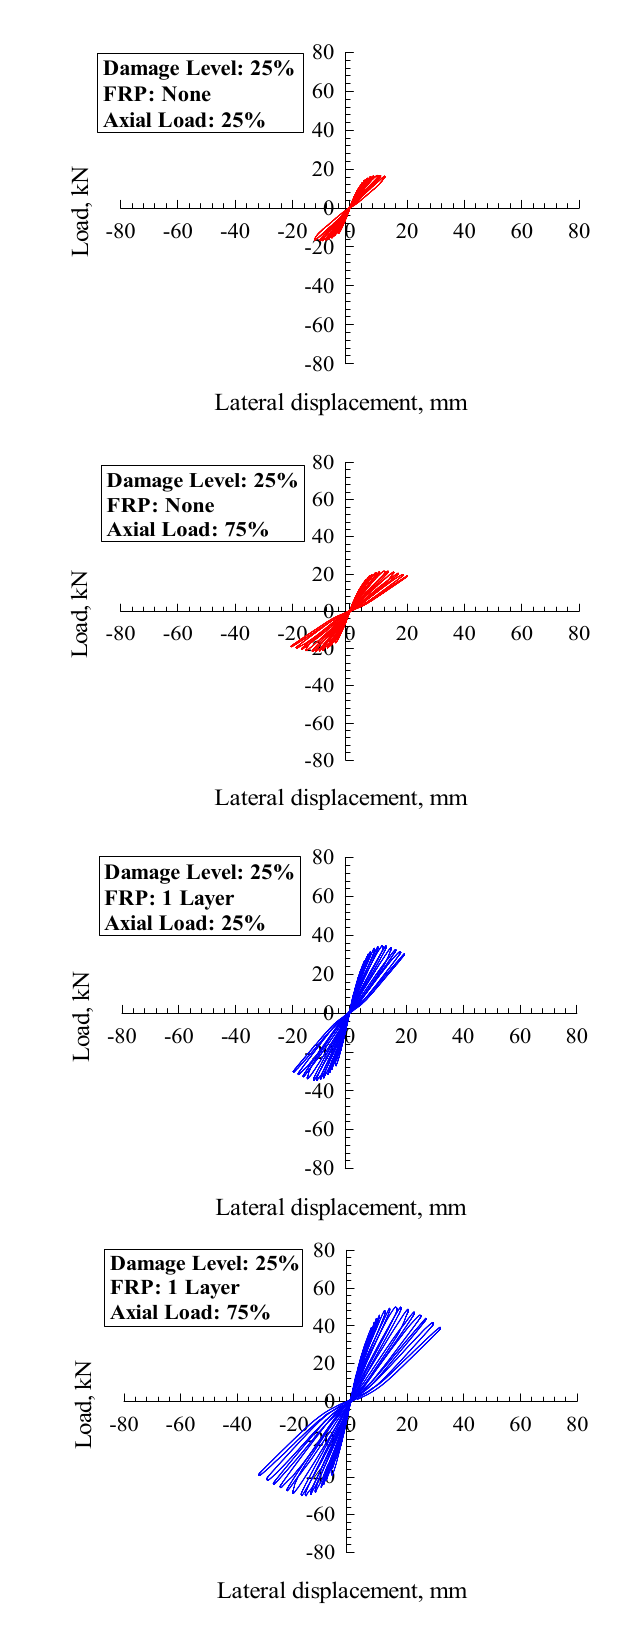
Figure 8. Hysteretic loops for undamaged joints.